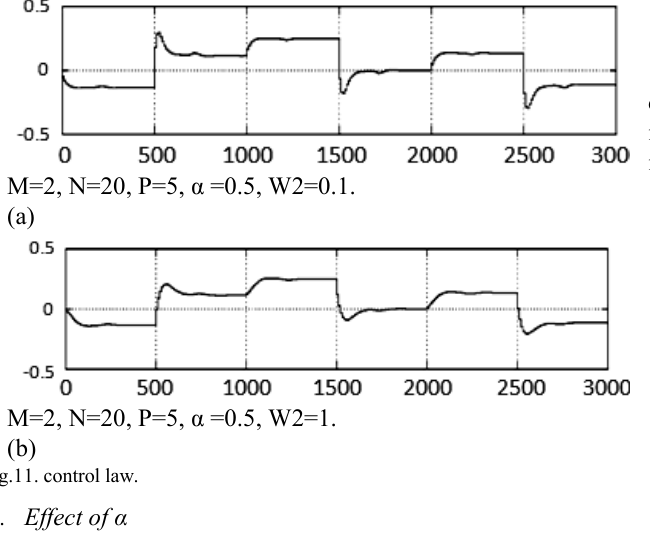
Fig.14.elliptical path.